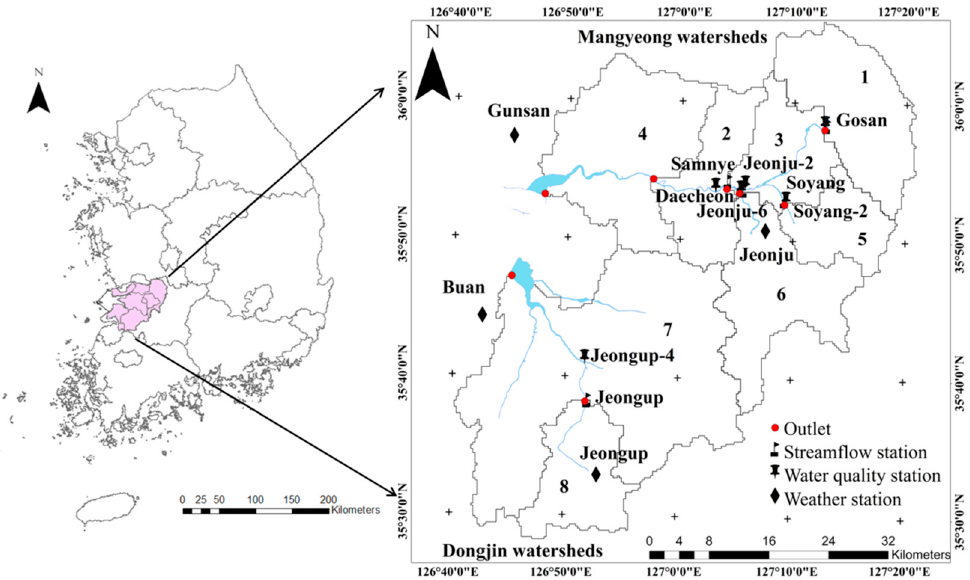
Figure 1. Location of the study area in the Saemangeum watershed and sampling points.